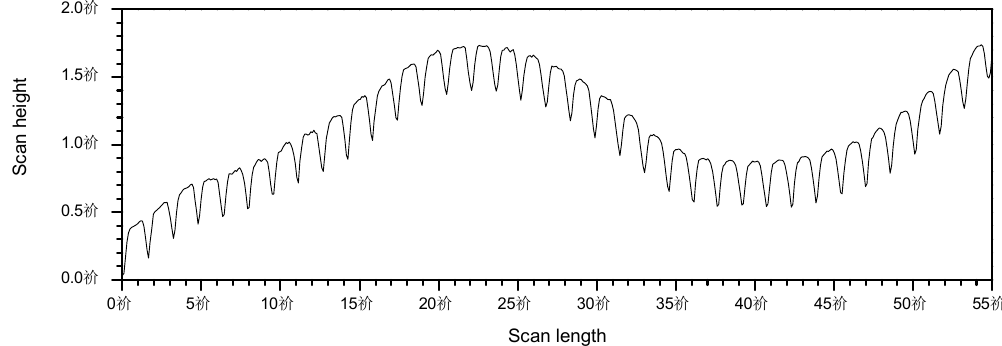
Figure 10. AFM linescan taken on the final imprint. The location is indicated by the dashed line in the lower right AFM image in Figure 9. Again, the height of both types of structures is well preserved from the individual masters to this final imprint.